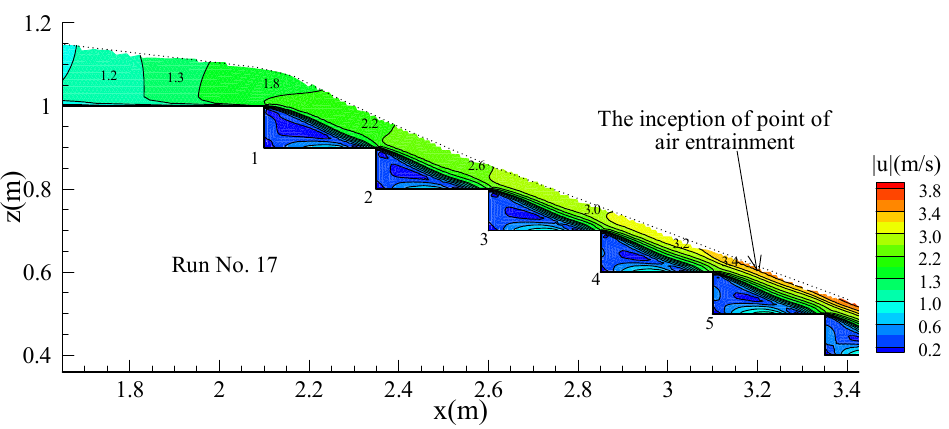
Figure 16. Numerical contour map of mean flow velocity u at Run No. 17.